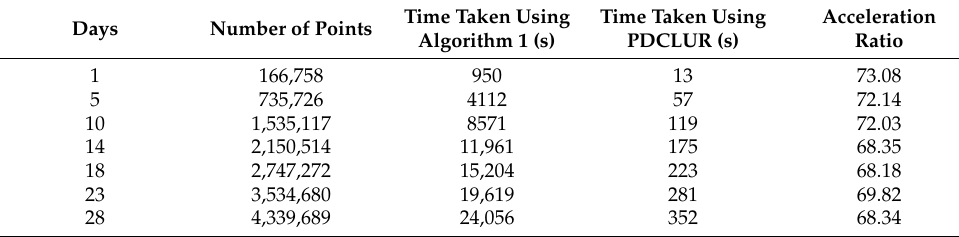
Table 2. Performance comparison between PDCLUR and Algorithm 1 during morning peak.